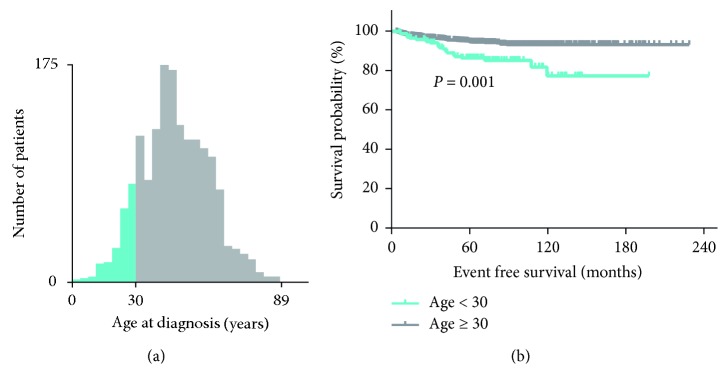
Analysis of age at diagnosis by X-tile software. (a) X-tile determined cutpoint of age and divided patients into high- and low-risk groups. (b) Kaplan–Meier survival curves for EFS according to age stratifications.